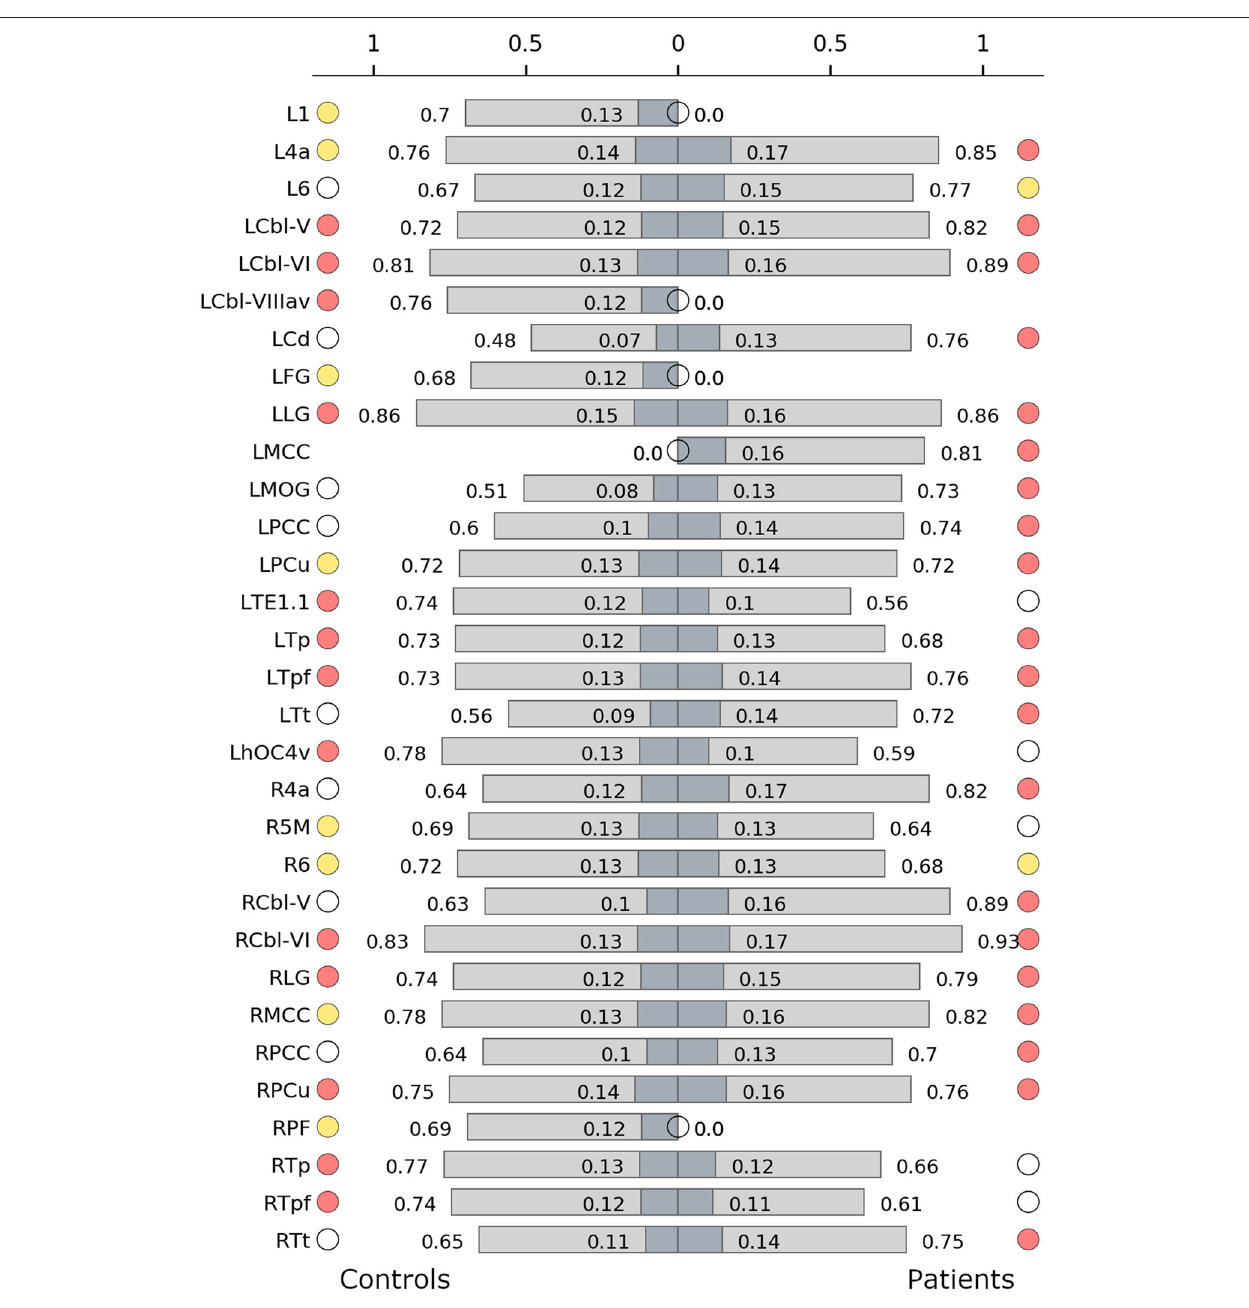
lobule VI, left posterior cingulate gyrus, caudate nucleus, right middle cingulate gyrus and cerebellar lobule V ( Figure 4 ). The left middle cingulate gyrus was the only shared provincial